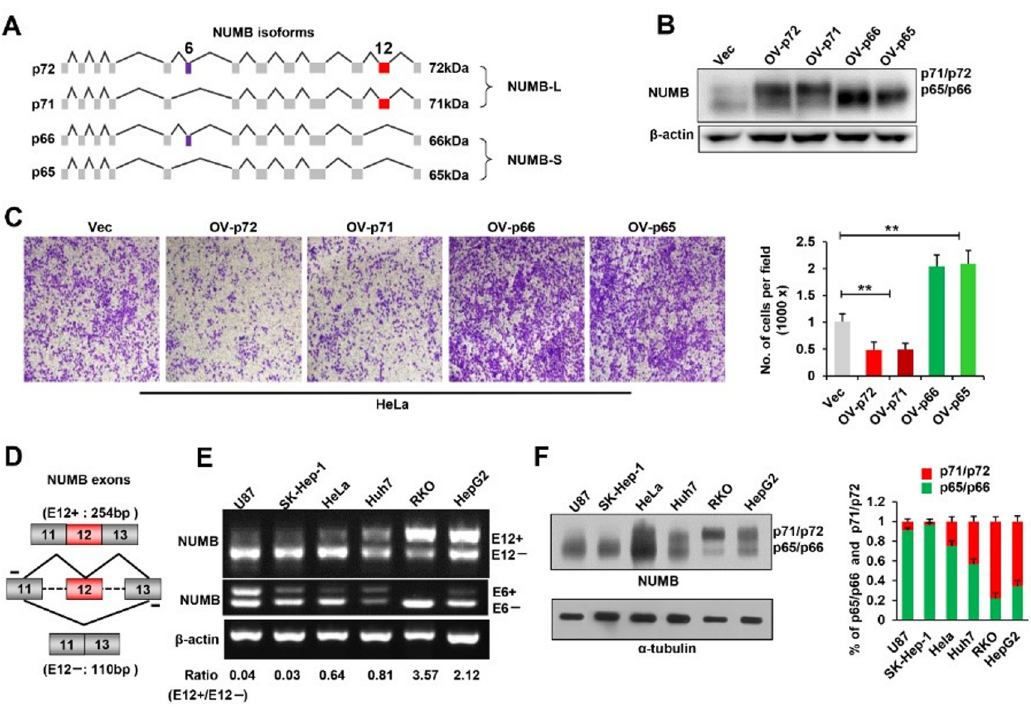
Figure 1. Expression of NUMB E12-skipping p65/p66 isoforms promotes cancer cell migration. ( A ) Schematic diagrams of NUMB splice variants. Constitutive exons are shown as grey boxes, whereas green and red boxes stand for alterative exons 6 and 12 (E6 and E12), respectively. ( B ) Overexpression of NUMB isoforms in HeLa cells. HeLa cells were transiently transfected with indicated expression plasmids. Whole-cell lysates were extracted and analyzed by Western blot. β -actin was used as a loading control. ( C ) Cell migration assay was performed with HeLa cells, as described in ( B ). Representative images of migratory cells stained with crystal violet are shown. Scale bar is 200 µ m. Quantification was based on the three independent experiments, and results are shown as mean ± SD on the right. ( D ) Diagrams for detection of NUMB variants including or lacking E12 using RT-PCR. Primer pairs and product sizes for the two variants E12+ and E12 − are shown. ( E ) Inclusion of NUMB E12 and E6 was examined in the six cancer cell lines by RT-PCR. Ratio for E12+/E12 − is listed below the panel. ( F ) Whole-cell lysates were extracted from the six cancer cell lines described in ( E ) and subject to Western blot analysis using indicated antibodies. Qualification of NUMB isoforms is shown in the right bar graph. ** p <